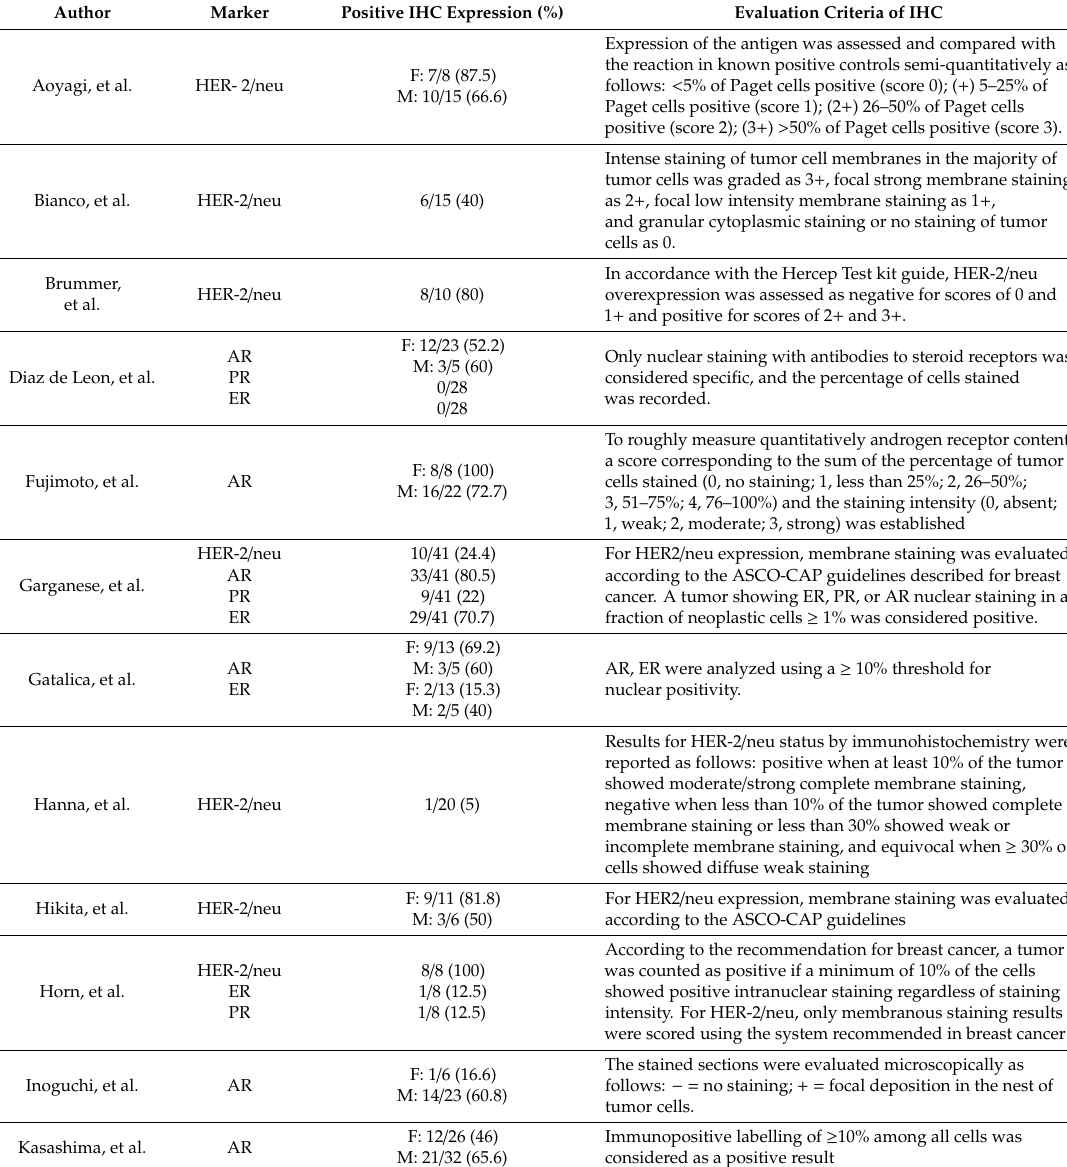
Table 3. Evaluation of immunohistochemical markers in the selected